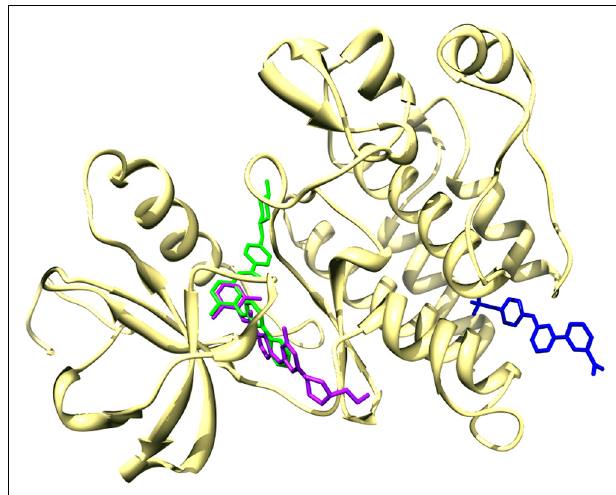
FIGURE 1 | Binding of theABL kinase with dasatinib (type I inhibitor, shown in purple), imatinib (type II inhibitor, shown in green), and GNF-2 (type IV inhibitor, shown in blue). The human ABL kinase co-crystallized with imatinib (PDB code 1IEP) was used as reference for the structural superposition of the human ABL co-crystallized with dasatinib (PDB code 2GQG) and of the mouse ABL in complex with the allosteric inhibitor GNF-2 (PDB code 3K5V). Only the ribbon representation of the human ABL kinase domain from 1IEP (chain A) is shown.